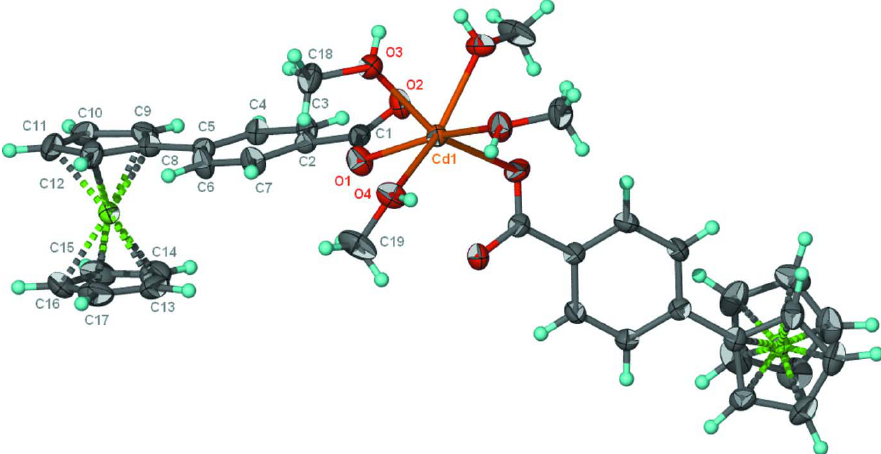
Figure 1 The molecular structure of (I) at the 50% probability level (arbitrary spheres for the H atoms). The unlabelled atoms are generated by the symmetry operation (1–x, 1+y,